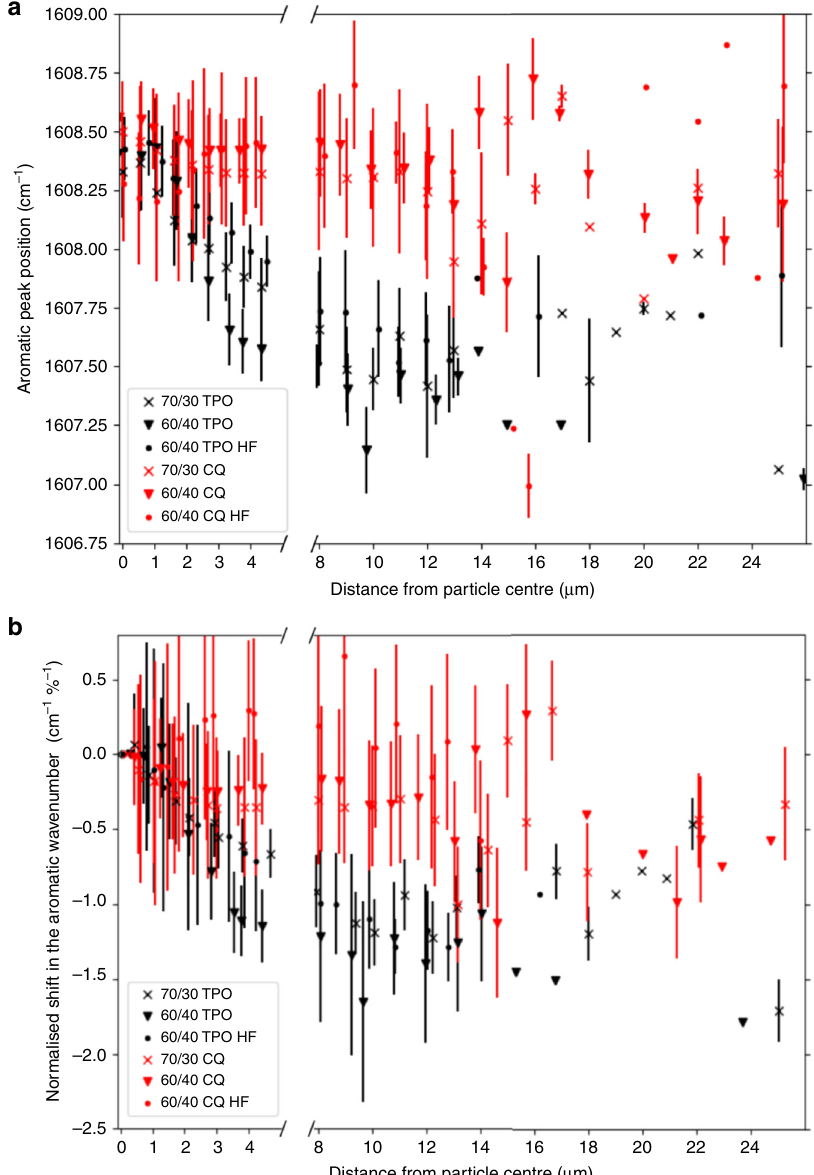
Fig. 5 Inter-particulate residual aromatic strain. a The peak position for the absorption band corresponding to the aromatic group at the centre of the Bis- GMA monomer as a function of distance from a fi ller particle centre. Radially averaged wavenumber values (over all particles, centre to edge) are shown to the left of the axis break, while wavenumber values at the midpoint between particle centres are shown to the right. b The shift in the aromatic wavenumber (an increase in residual strain), normalised to the degree of reactive group conversion at each distance increment. Error bars are reported as the standard deviation of radial and inter-particulate measurements. Jitter has been added to for